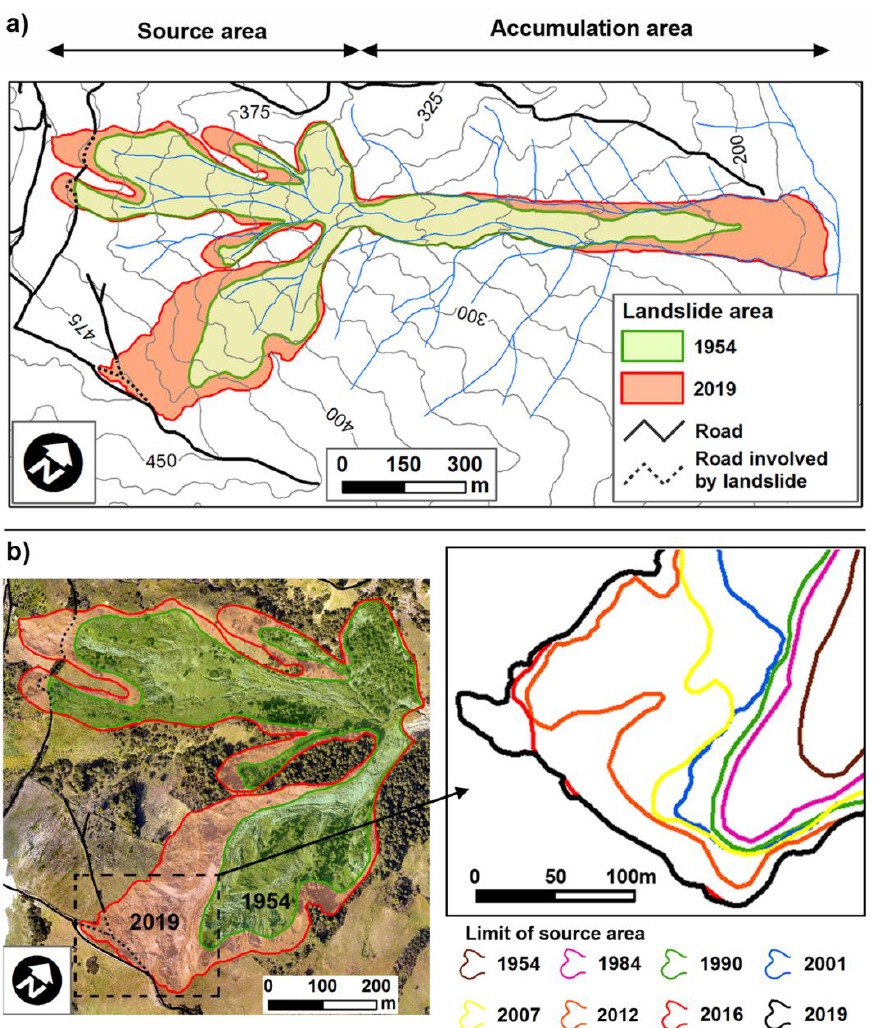
Figure 8. Morphological changes of the Vomice earthflow: ( a ) areal variations of the earthflow from 1954 to 2019, ( b ) limits of enlargement of the earthflow source area during the time intervals considered.